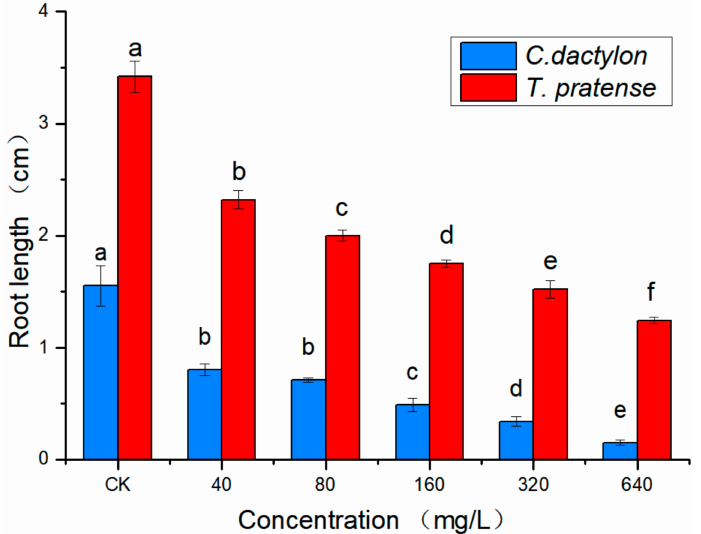
Figure 1. Effect of the ethanol extract of S. mukorossi pulp on the root growth of T. pratense and C. dactylon . The freeze–dried samples in water agar (0.5% agar) were set at 40, 80, 160, 320 and 640 mg/L. CK: untreated plants (control). Root length was recorded after four days of cultivation for T. pratense and seven days for C. dactylon. Values represent the means ± standard deviation (SD) from three replicates with ten seedlings. Different letters (a, b, c, d, e and f) indicate significant differences among treatments by ANOVA ( p =